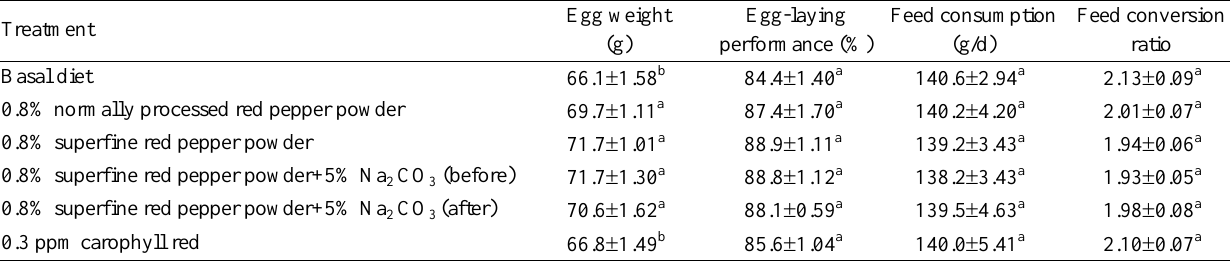
Table 4. Effect of red pepper powder on the production performance of laying hens (Exp. 2) 1 Treatment